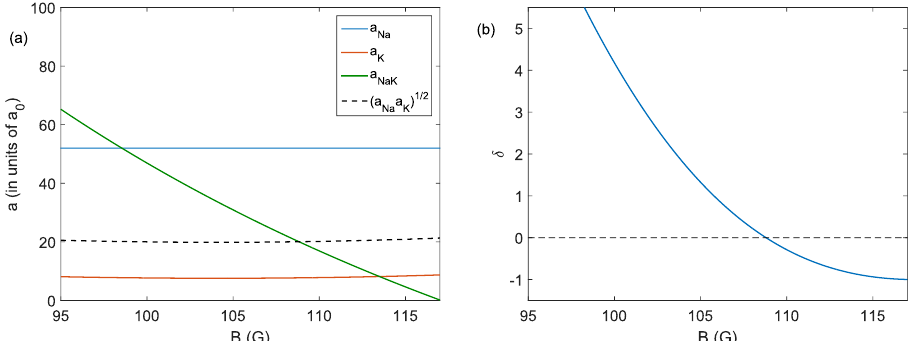
Figure 1. ( a ) Scattering lengths as a function of the magnetic field for the intra-species interactions of 23 Na, a Na (in blue), and 39 K, a K (in red), and for the inter-species interaction a NaK (in green) considering both atoms in the F = 1, m F = − 1 hyperfine state. The black dashed line given by ( a ) 1/2 represents the value of a Na a K NaK for which the system changes from immiscible to miscible with δ = 0. ( b ) Miscibility parameter as a function of the magnetic field. At B = 109.1 G with δ = 0 the system changes from immiscible to miscible when increasing B